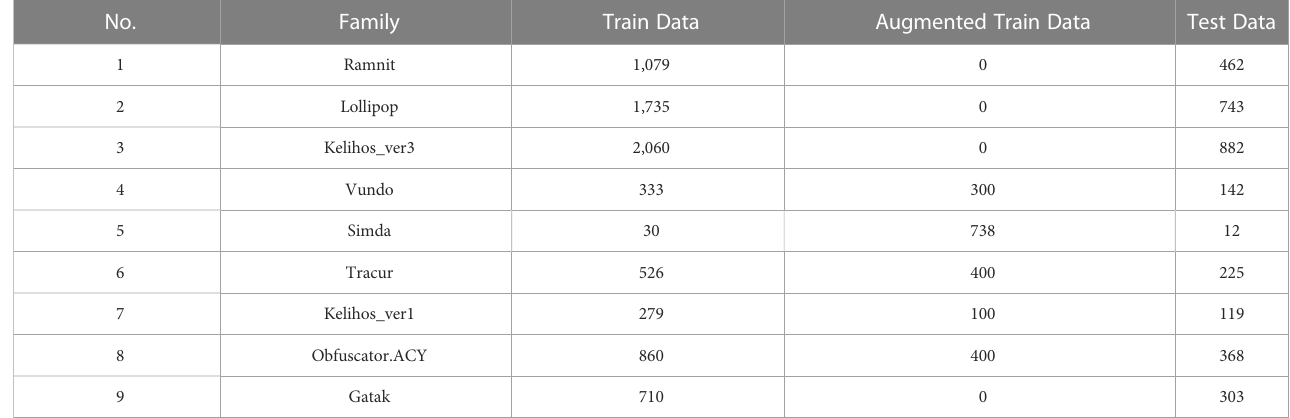
TABLE 2 The number of trainings, augmented trainings, and test data for BIG2015. No.